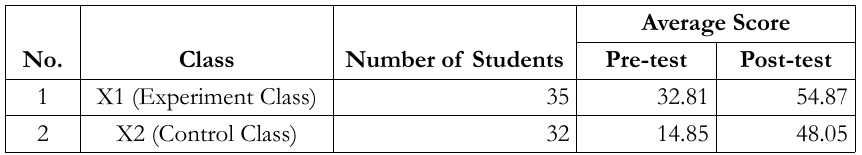
Table 6. The average score of learning